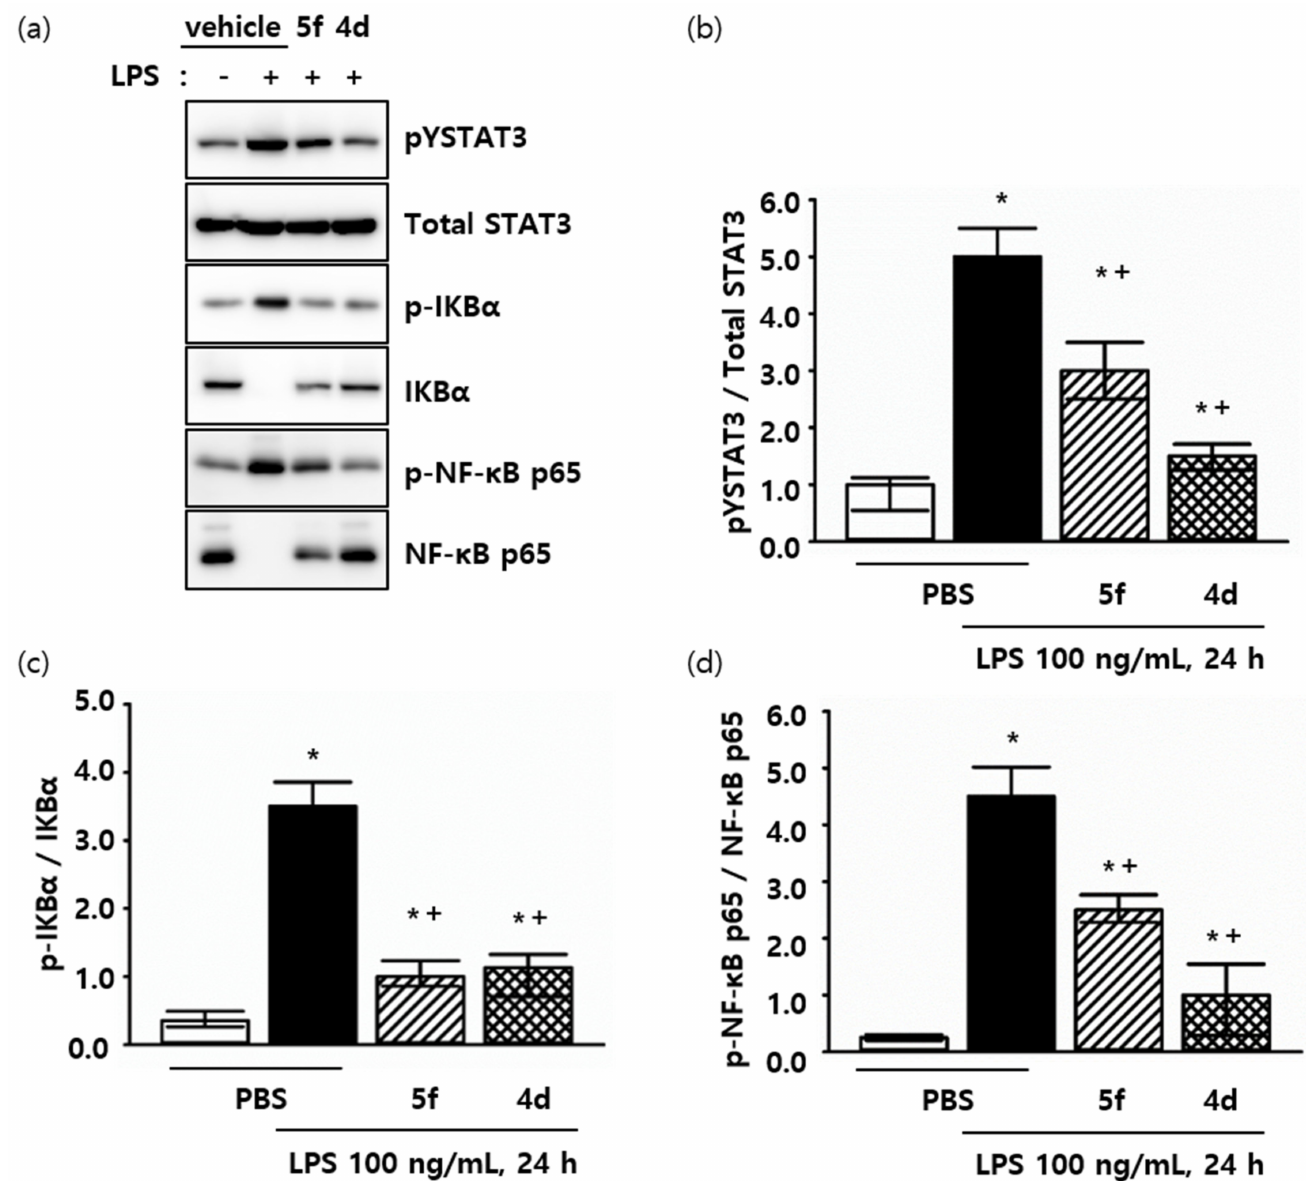
Figure 2. Compounds 5f and 4d attenuate inflammation in vitro. Effects of compounds (10 µ M) on the protein levels of STAT3, I κ B, and NF- κ B in AML-12 cells. ( a ) Expression levels of inflammation related-proteins in vitro. ( b – d ) Protein expression levels were normal-ized against the indicated protein. * p < 0.05 compared with the group treated with the PBS (vehicle). + p < 0.05 compared with the group treated with the LPS. Data are pre-sented as the mean ±